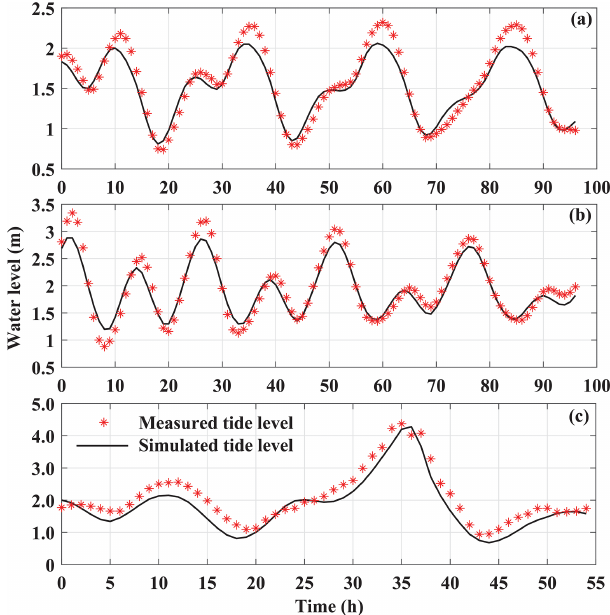
Figure 3. The simulation results of astronomical tide and storm tide compared to measured tide levels. (a) Astronomical tide at Xiuying gauge station. (b) Astronomical tide at Naozhoudao gauge station. (c) Storm tide at Xiuying gauge station. Black lines indicate the simulated tide level; red asterisk points indicate measured tide